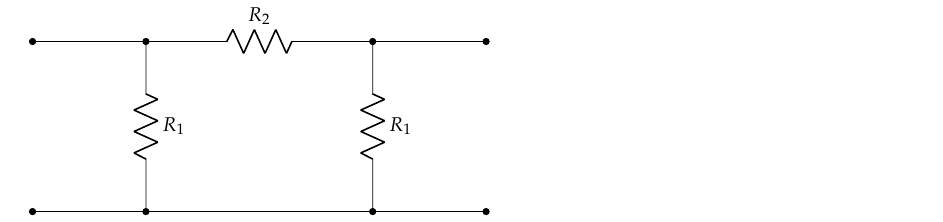
Figure 1. A simple reciprocal, energetically passive π -network, with two shunt resistors R 1 and a series resistor R 2